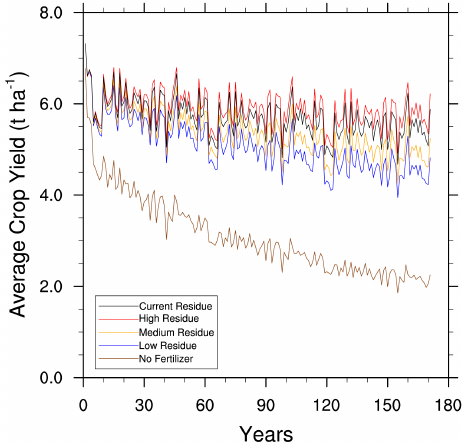
Figure 6. Simulated change in total US SOC (PgC) due to agricul- tural land management for all scenarios.